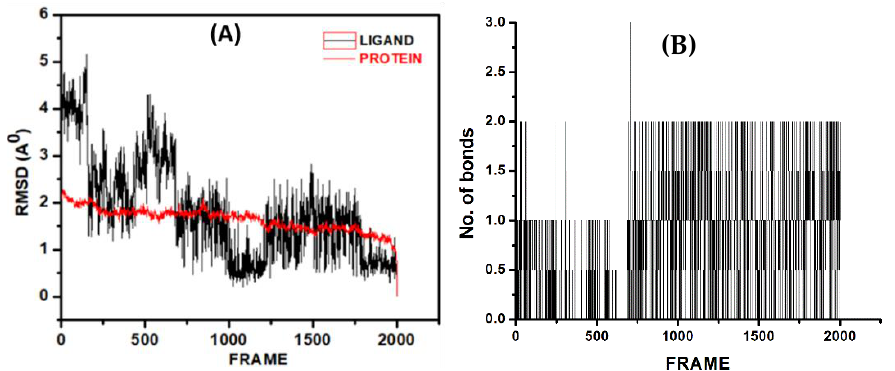
Figure 11. ( A ) Root mean square deviation plot, and (B ) Hydrogen bond formations.